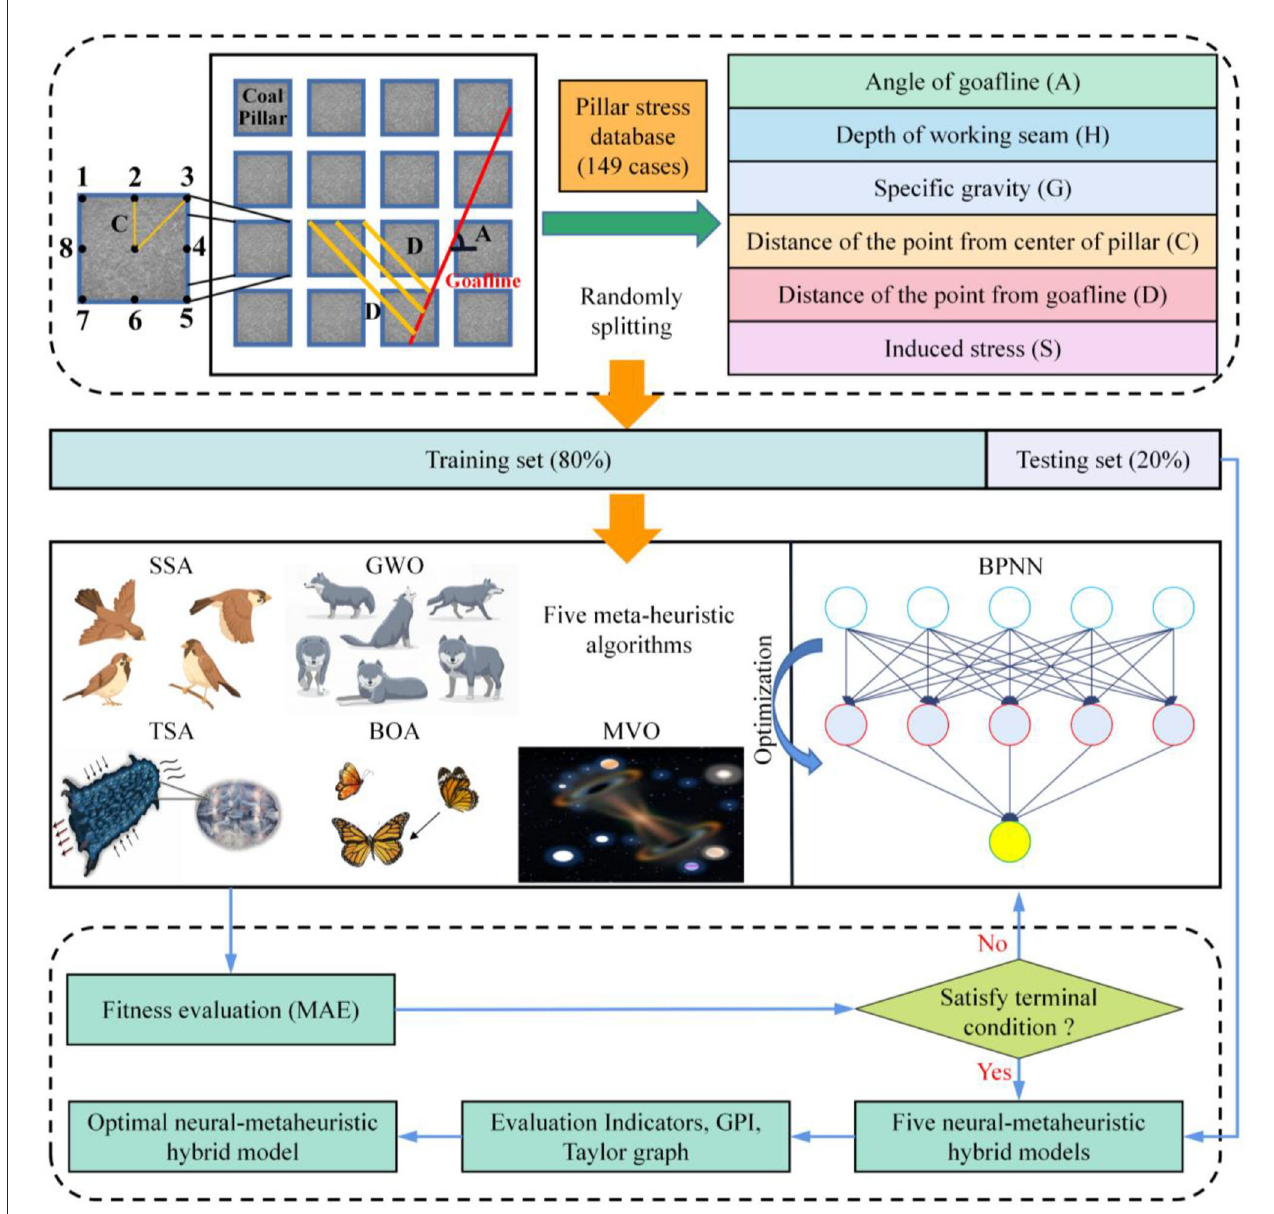
FIGURE5 Flowchart of SSA-BP, GWO-BP, BOA-BP, TSA-BP, and MVO-BP prediction models.